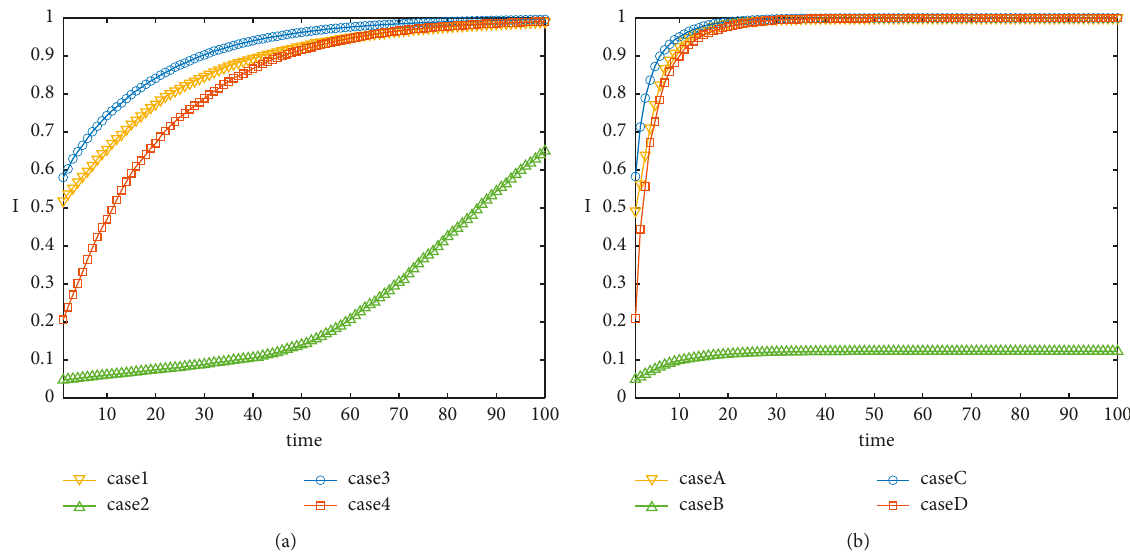
Figure 6: Comparison of the information amount in different scenes. In the long term, it shows the average information amount with time and matches the previous 8